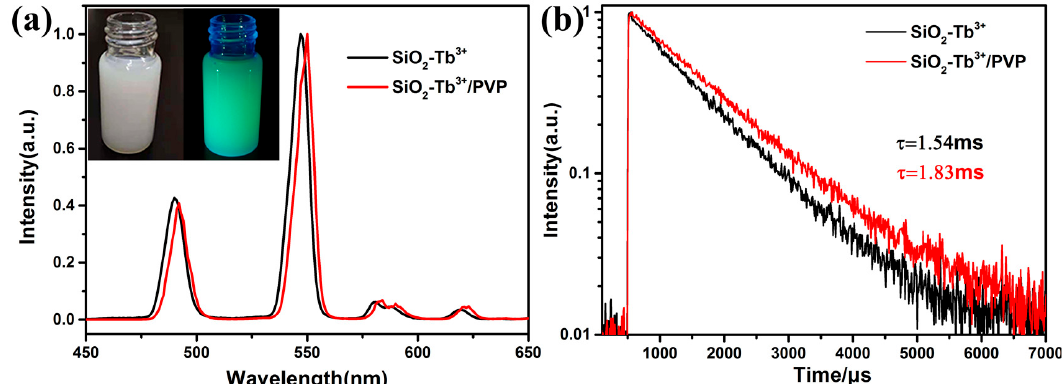
Figure 6. Emission ( a ) spectra and the 5 D 4 – 7 F 5 emission decay curves ( λ ex = 325 nm) ( b ) of SiO 2 –Tb 3+ hybrid nanoparticles and SiO 2 –Tb 3+ /PVP nanofibers at 548 nm. The inset of the Figure 6a is SiO2@Tb(acac)3phen/PVP spinning solution under 365 ultraviolet